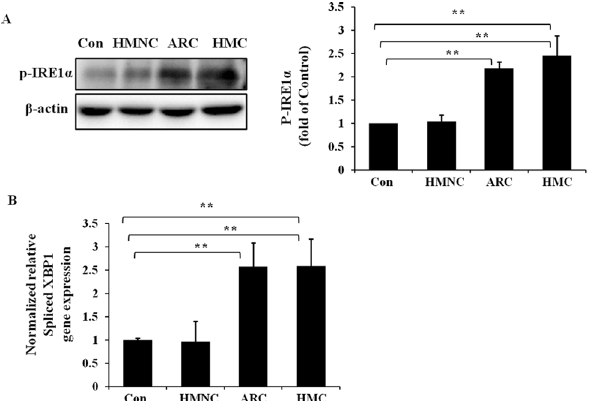
Fig 3. Up-regulation of p-IRE1 α protein level and spliced XBP1 gene expression level in the lens epithelium of HMC patients. RNA and protein were extracted from HMC, HMNC, ARC or normal control (Con) human epithelium specimens. Western blotting was performed to detect the protein expression of p- IRE1 α (Fig 3A), and β -actin was used as the internal control. Real-time PCR was performed to detect the relative gene expression levels of spliced XBP1 in each group (Fig 3B), and 18S was used as the internal control gene (mean ± SD, n = 3). * P < 0.05; ** P < 0.001.